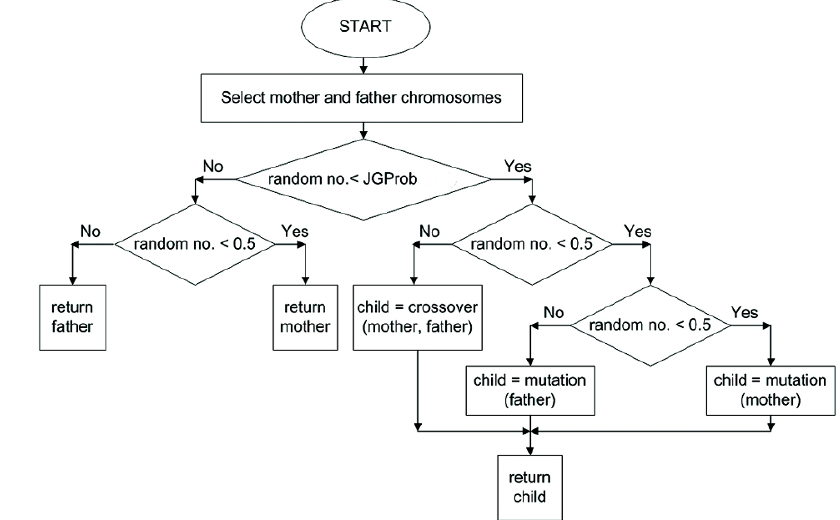
Figure 1. Flowchart of the jumping genes